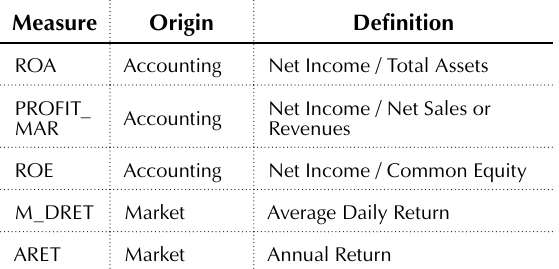
Table 2. Profitability